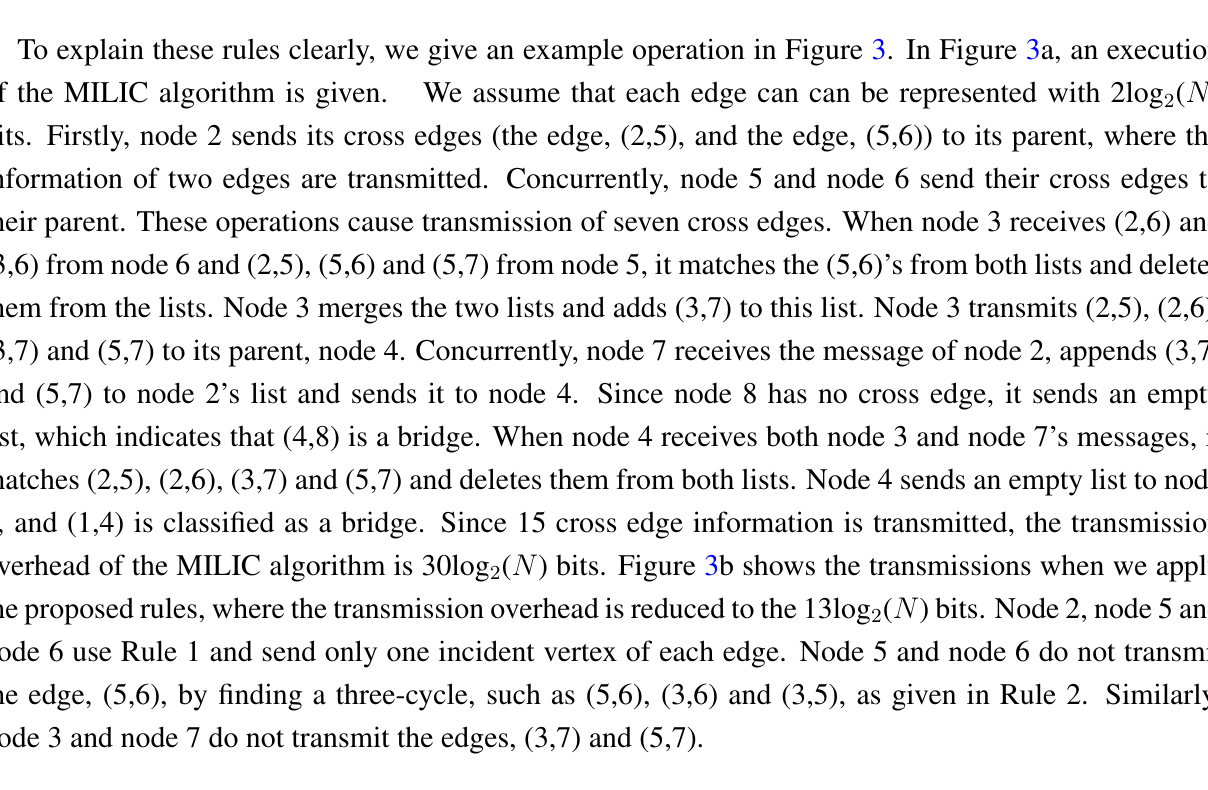
Figure 3. MILIC and extended-MILIC (E-MILIC)